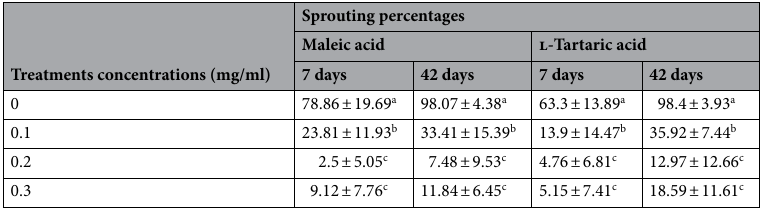
Table 3. Sprouting percentage data of the control and treated potato tubers after the first 7 days and at the end of the 42 days storage period post treatment. The data is represented as mean ± SD. The values with different superscripts “a,b,c” are significantly different along the